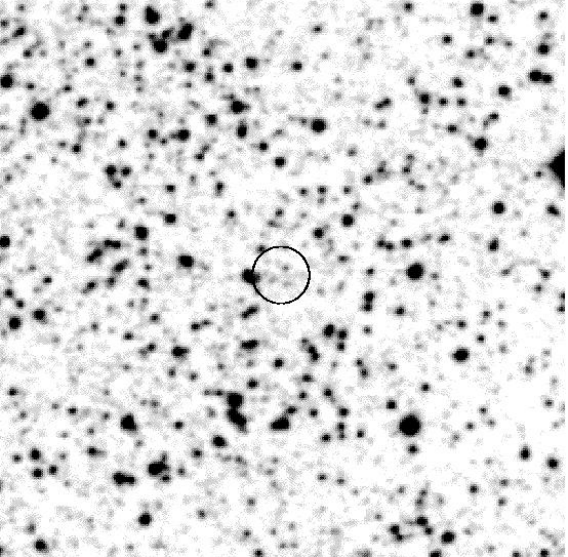
Figure 3: This finder chart for V906 Ophiuchi (Nova Ophiuchi 1952) from the online version of the Cata- log and Atlas of Cataclysmic Variables (Downes et al.